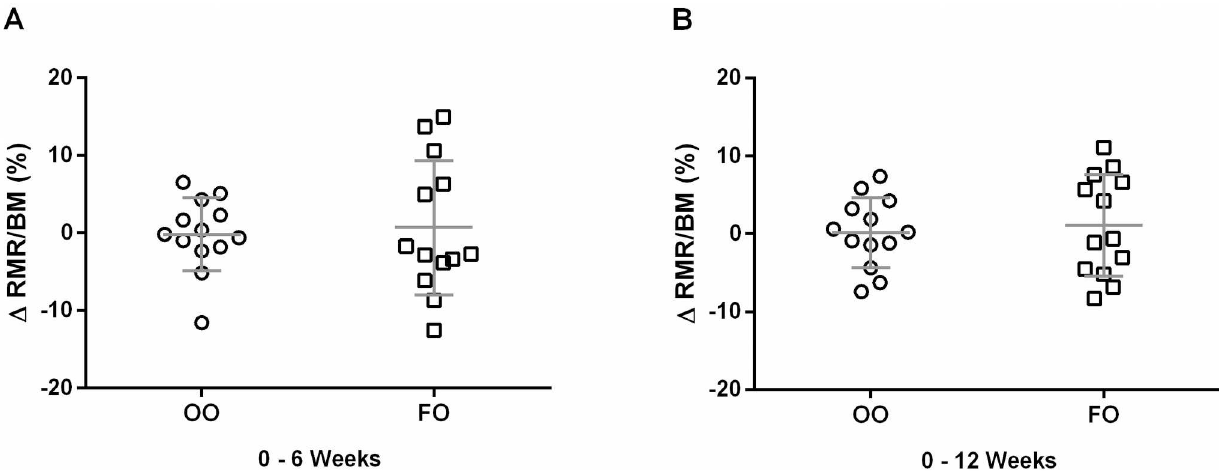
Fig 4. Change (%) in resting metabolic rate (RMR) normalized to body mass (BM) after 6 (A) and 12 (B) week supplementation of olive oil (OO) and fish oil (FO). Values are reportedas means ± SD. There were no differences betweenthe groups.